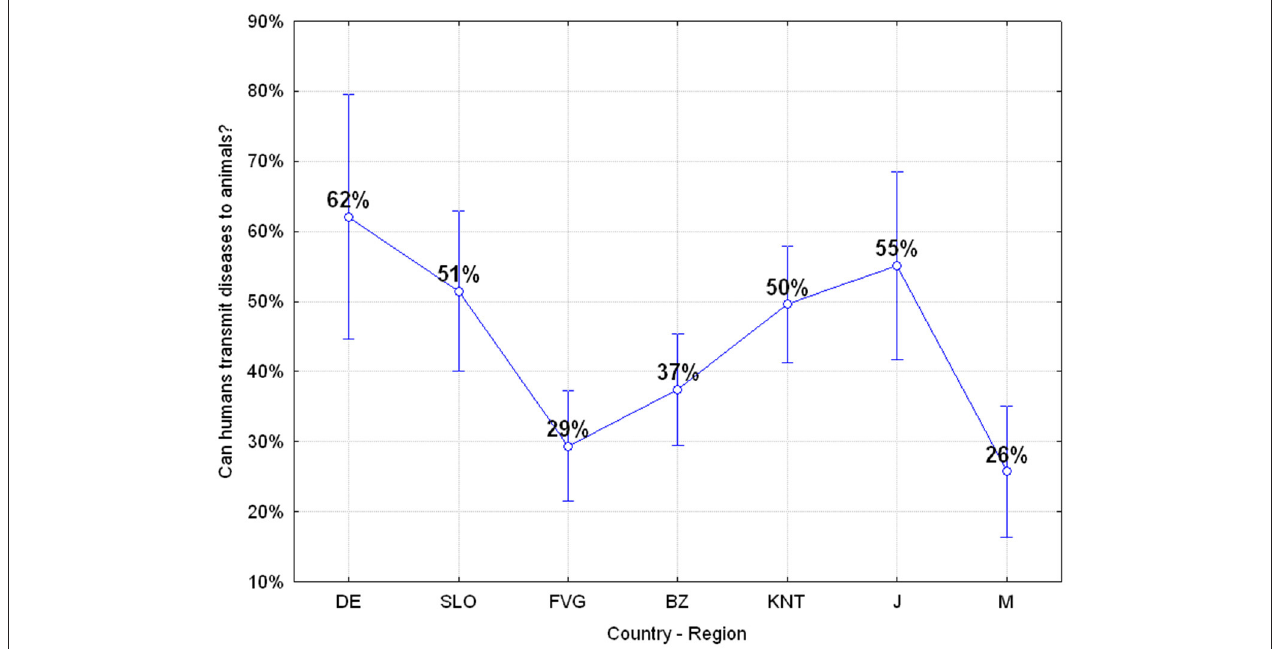
FIGURE 11 | Q25: “Can humans transmit diseases to animals?” ANOVA F (6,649) p = 0.00000 [Axes X regions or countries, Axes Y % correct answers–DE, Germany; SLO, Slovenia; FVG, Friuli Venezia Giulia Italy; BZ, Autonomous Province of Bolzano Italy; KNT, Carinthia Austria; J, Japan; M, Mauritius–( n = 656)].